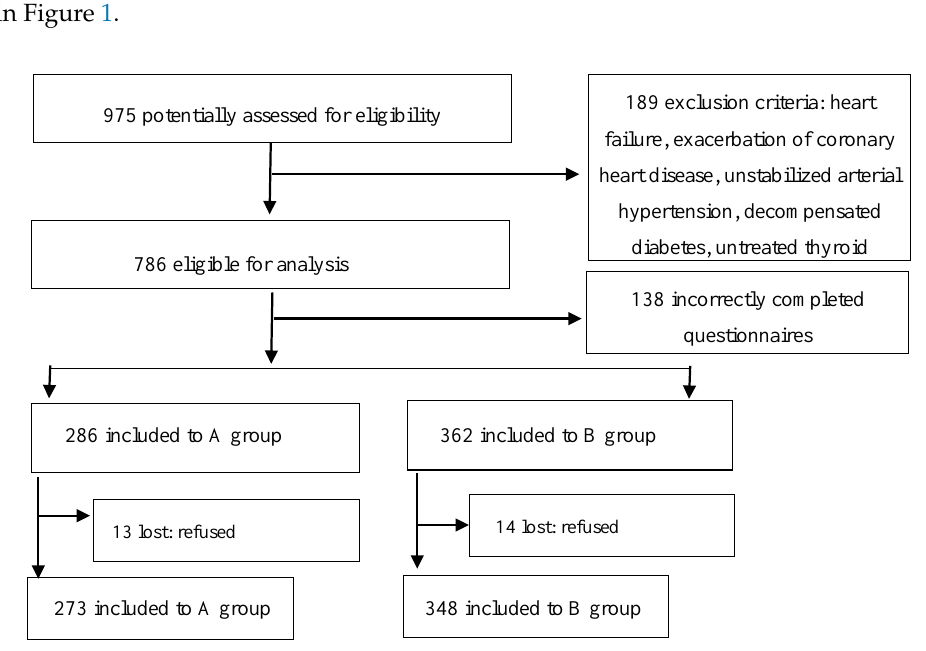
Figure 1. Visual insight into the participants selection procedure.